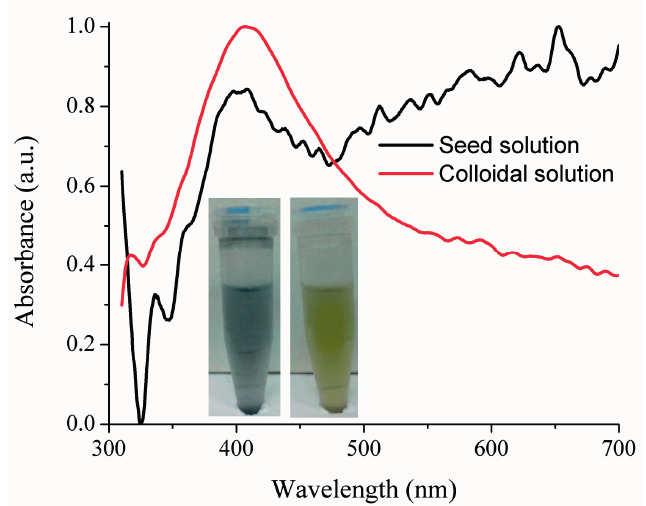
Figure 3. Absorbance spectra of seed and colloidal